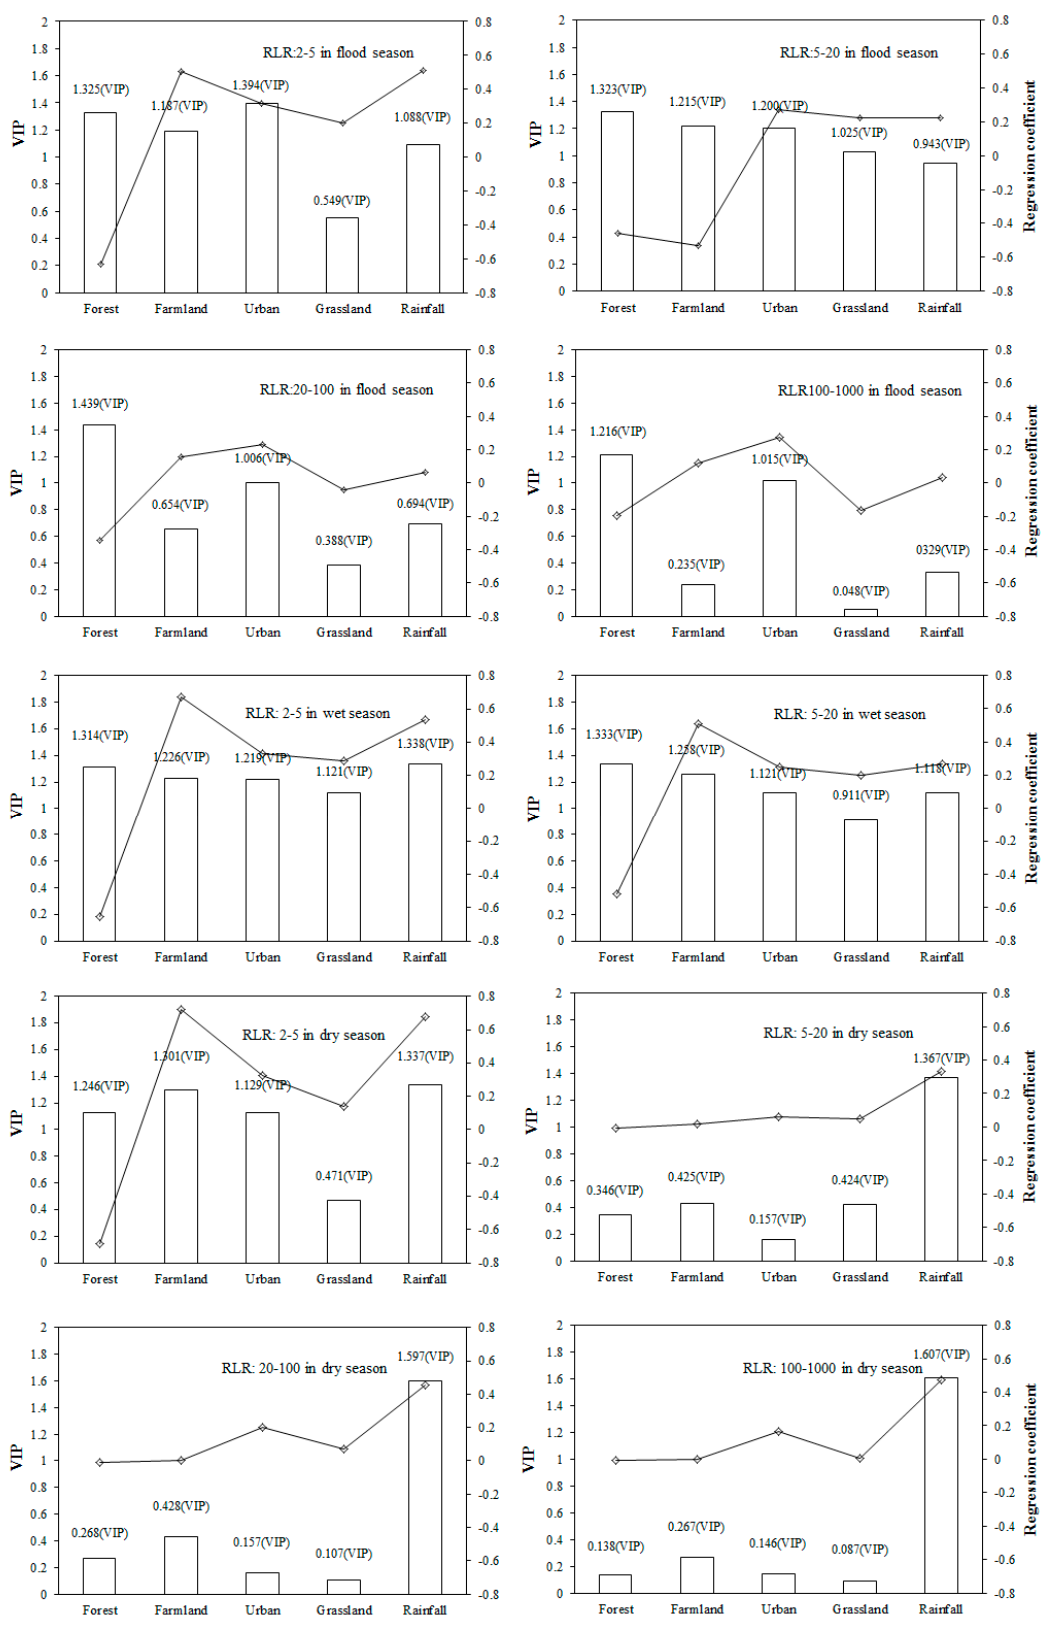
Figure 7. Regression coefficients (lines) and the variable influence on projection (VIP) (bars) of each factor.